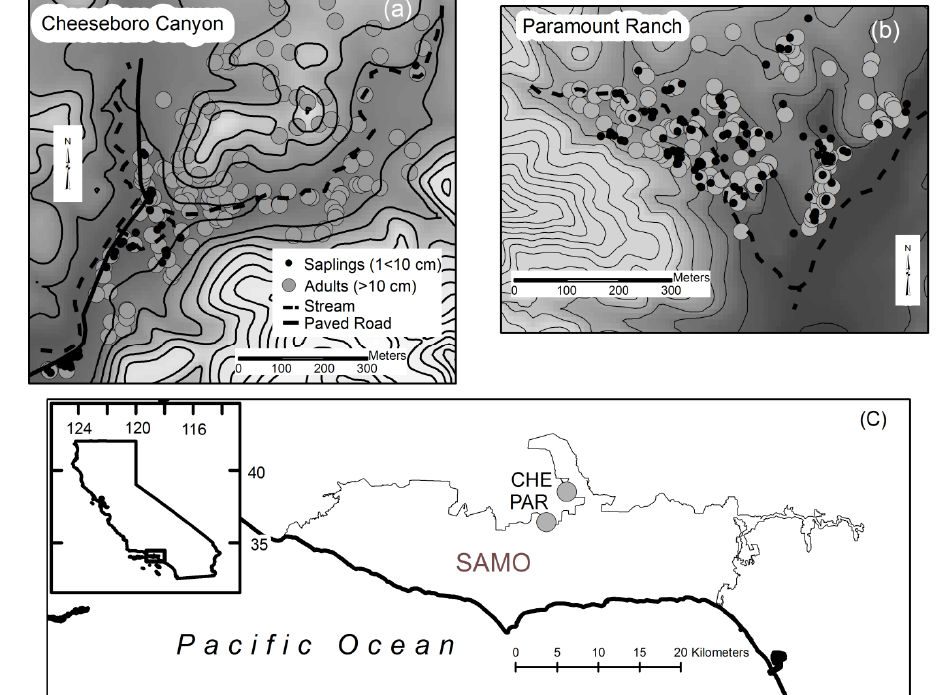
Figure 1. Sapling and adult stems are mapped on a 7 m contour interval map shown against a 10 m DEM. ( a ) Saplings at Cheeseboro Canyon (CHE) are found primarily along the stream and road corridor on the west side of the site; ( b ) Saplings at Paramount Ranch (PAR) are distributed similarly to adult stems; ( c ) The study sites are located approximately 5 km apart on the north slope of the Santa Monica Mountains National Recreation (SAMO) in southern